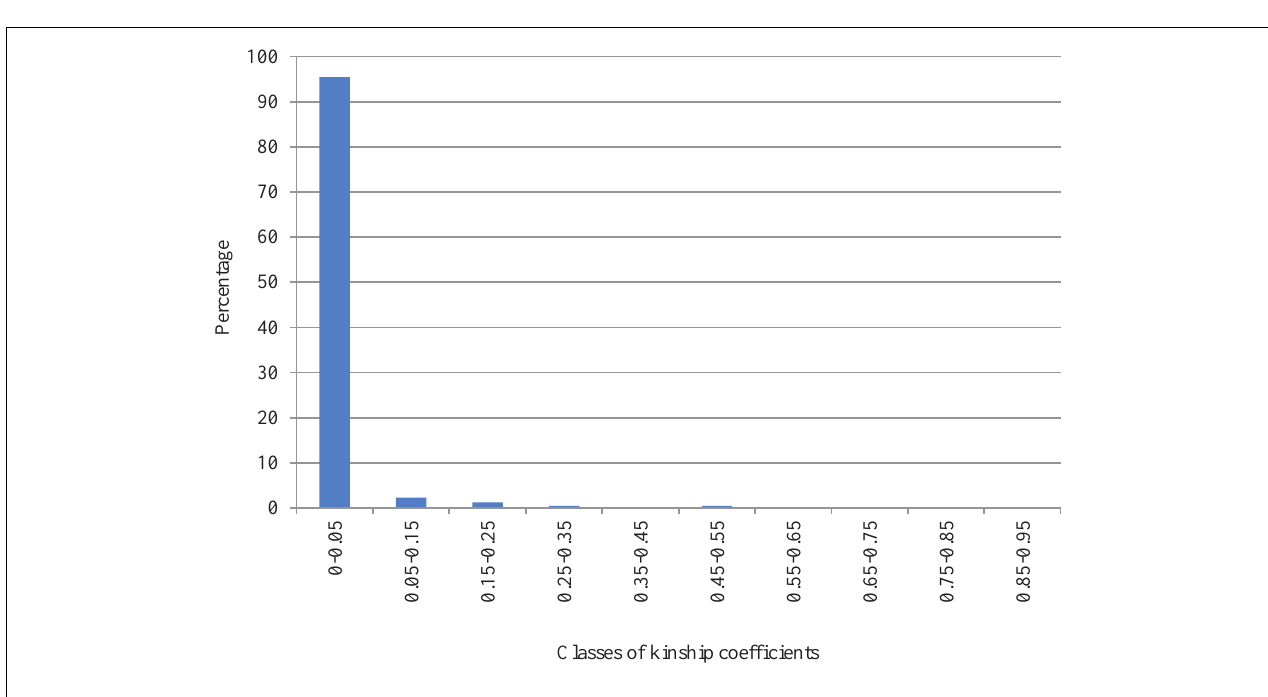
FIGURE 5 |The distribution of kinship relative coefficients between 96 B. napus accessions of panel